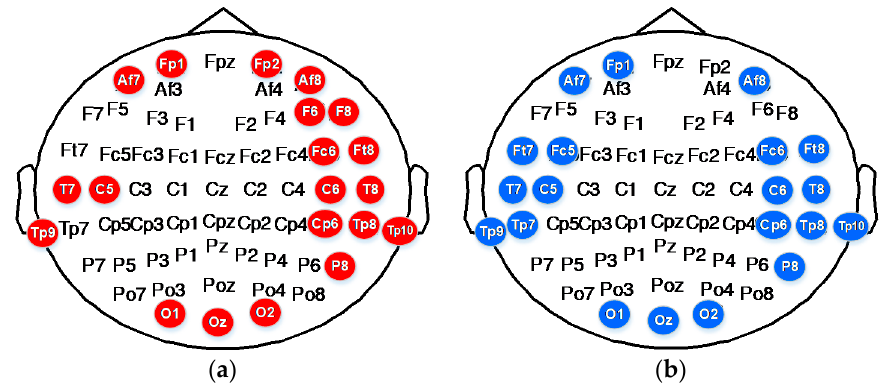
Figure 12. Distribution of top 20 subject-independent features selected on the basis of MRMR ranking. ( a ) Movie-induced emotion recognition. ( b ) Self-induced emotion recognition.